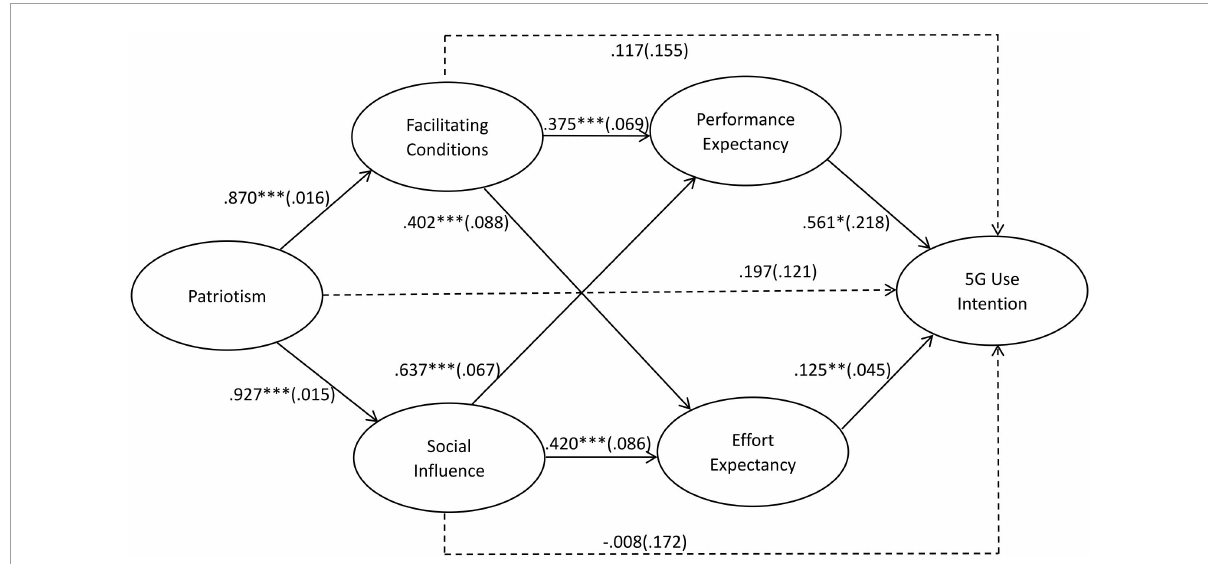
FIGURE2 Statistical model of Chinese 5G use intention. N = 804. *p < 0.05, **p < 0.01, ***p < 0.001. Model fit, Chi-square value X 2 (549) = 1848.163, RMSEA = 0.054, CFI = 0.903, SRMR =